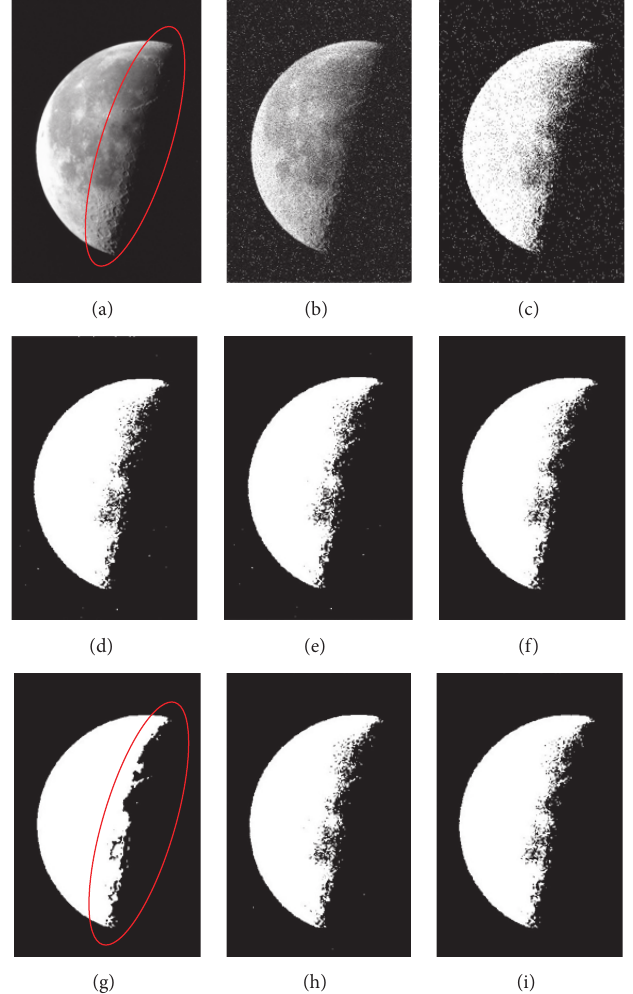
Figure 6: Segmentation result on moon image. (a) Original image. (b) Image corrupted by Gaussian and “Salt and Pepper” noise. (c) FCM result. (d) FCM S result. (e) FCM S1 result. (f) FCM S2 result. (g) RFCMLGI result. (h) RFCMLGI 1 result. (i) RFCMLGI 2